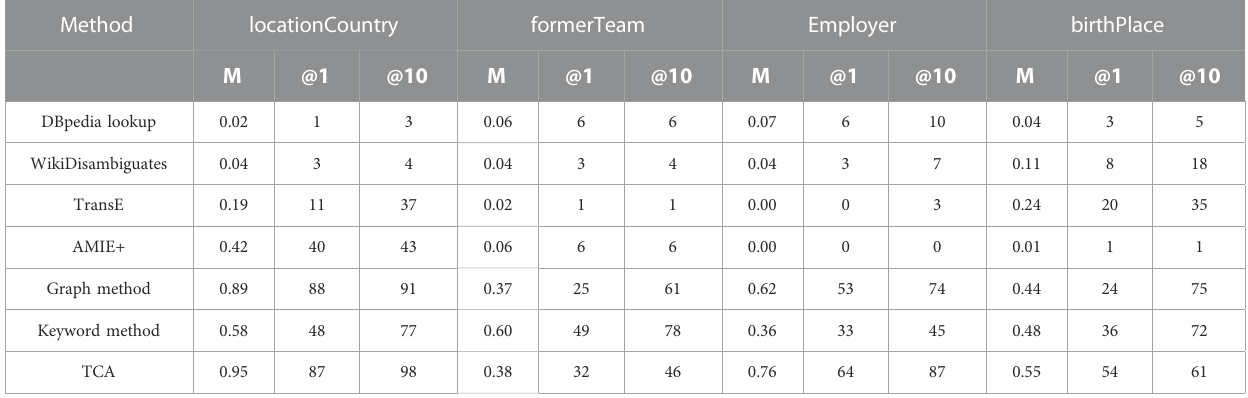
TABLE 4 Comparison of baseline methods. Method locationCountry